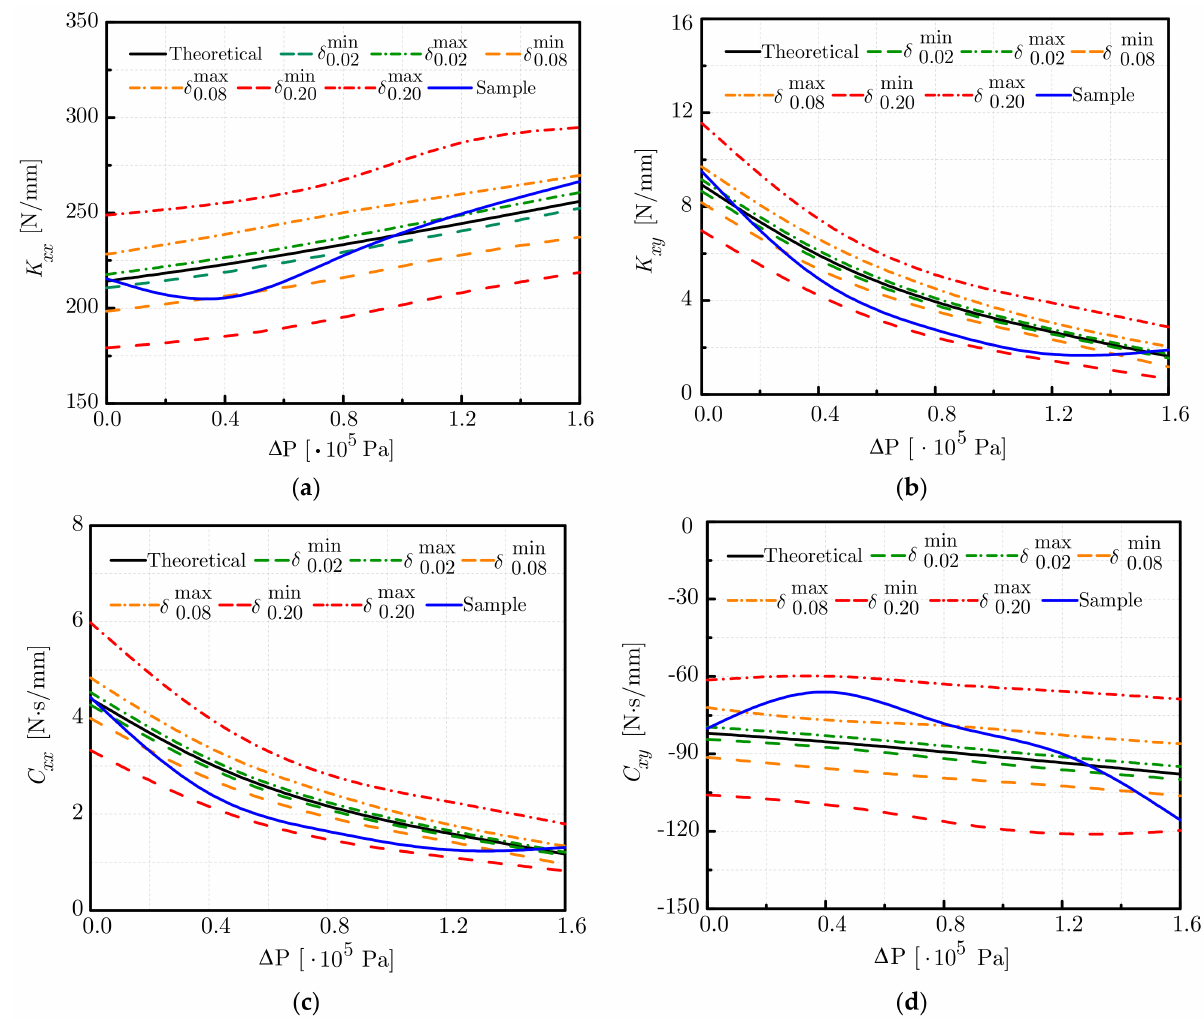
Figure 7. The envelopes of dynamic coefficients against pressure difference for δ R = 0.02, 0.08, and 0.20, where ( a ) is K xx , ( b ) is K xy , ( c ) is C xx , and ( d ) is C xy